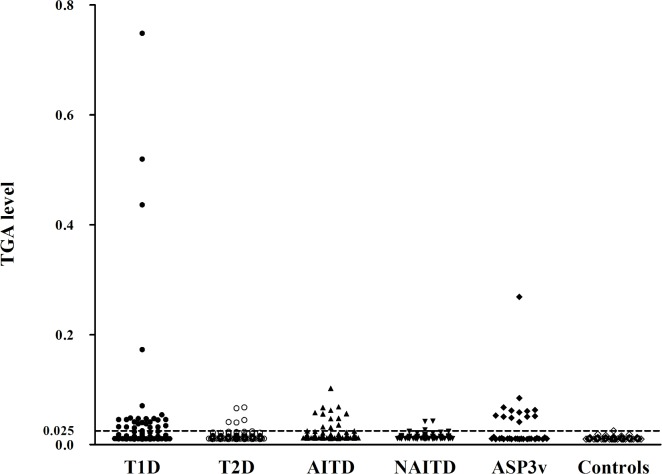
TGA levels in patients with T1D, T2D, AITD, NAITD and Controls.Data are expressed as antibody index of individual subjects from T1D, T2D, AITD, NAITD and Controls. The dotted line represents the cutoff value of TGA.